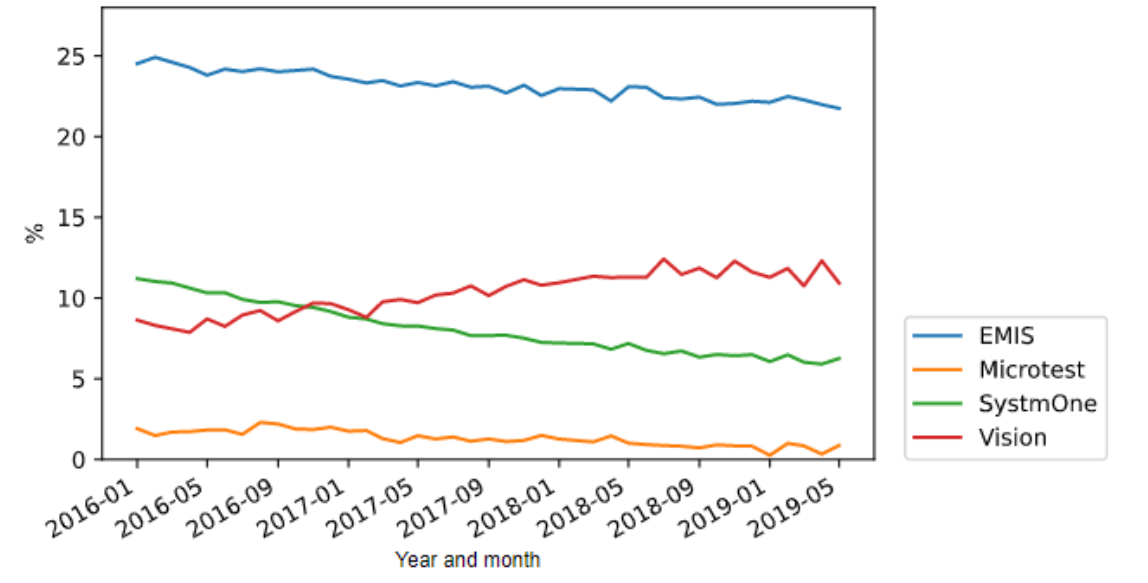
Figure 2. Mean values for the diltiazem safety breaches as a proportion of all prescribing by electronic health record (EHR).